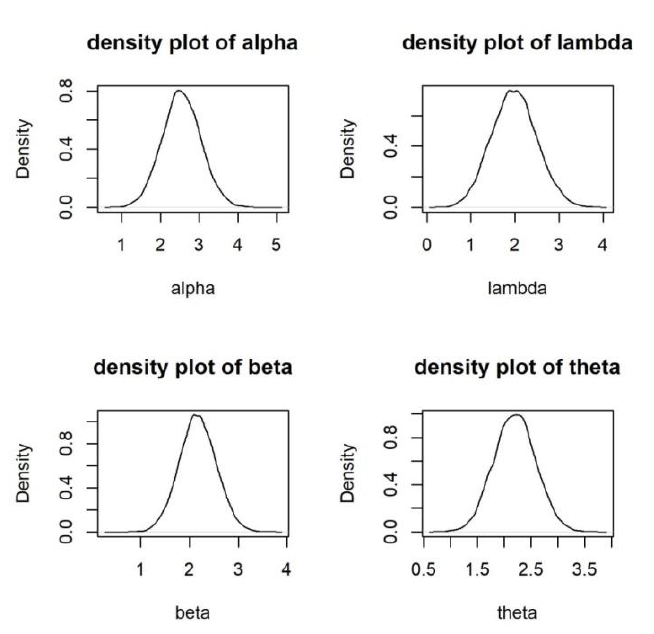
Figure 3. Density plots for 𝛼, 𝜆, 𝛽, 𝜃